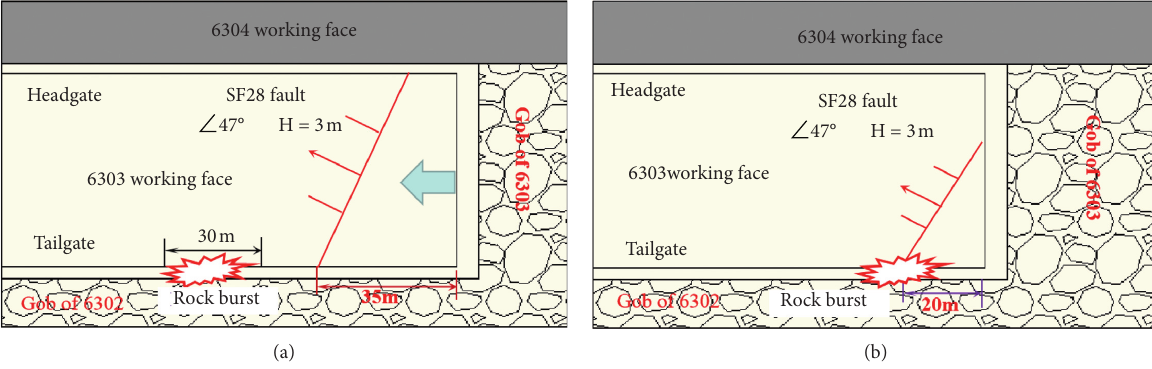
Figure 17: Location of a rock burst on an auxiliary roadway at 6303 in the Jining No. 3 Coal Mine. (a) The working face is 50m away from the fault. (b) The working face is 50 m away from the